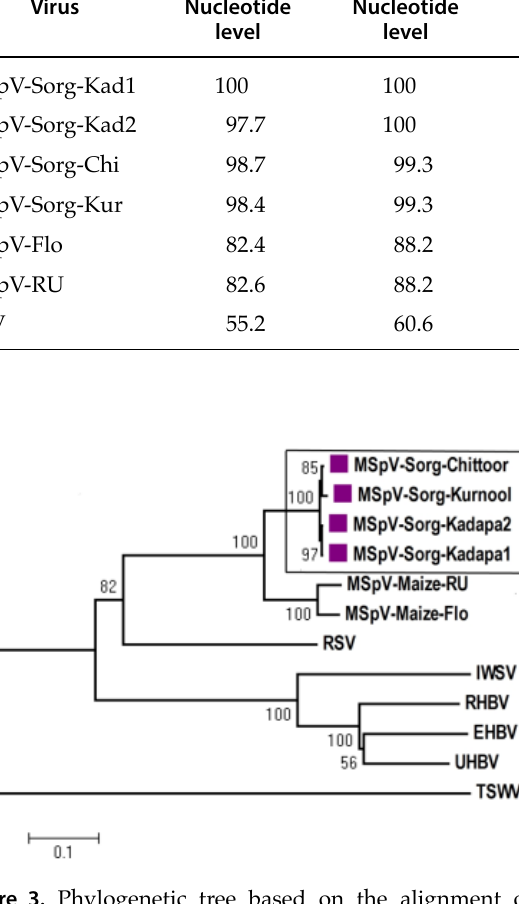
Table 2. Comparison of sequence identities of RNA3 of MSpV-Sorg isolates with MSpV-maize isolates. RNA3 Virus